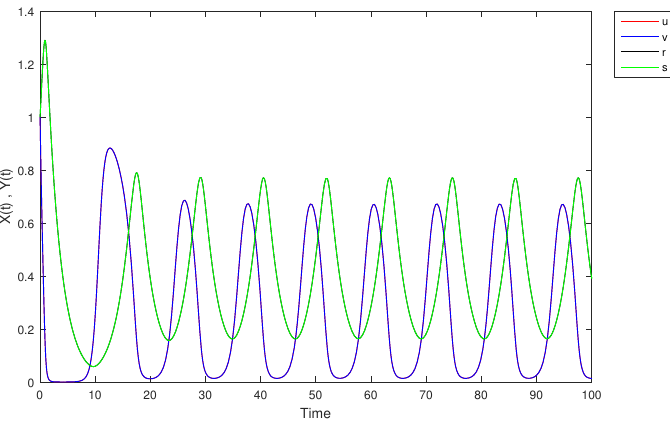
Figure 31. The solution of (13) at α =